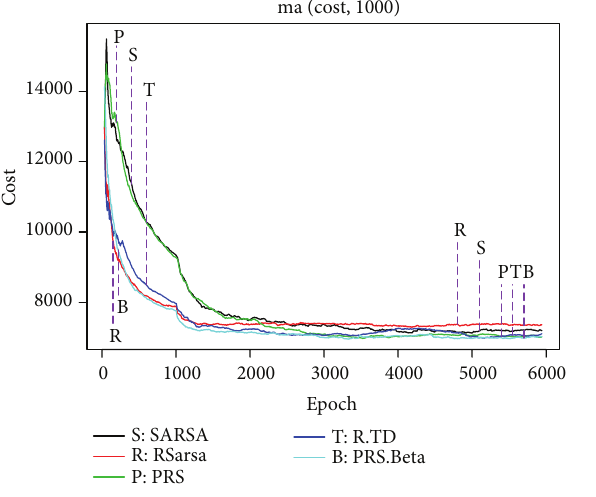
Figure 4: Moving average of period costs, P1.